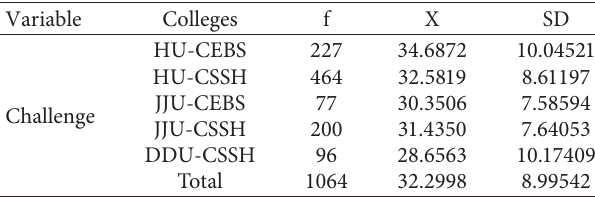
Table 5: Descriptive statistics for issues related to challenges of cooperative learning by